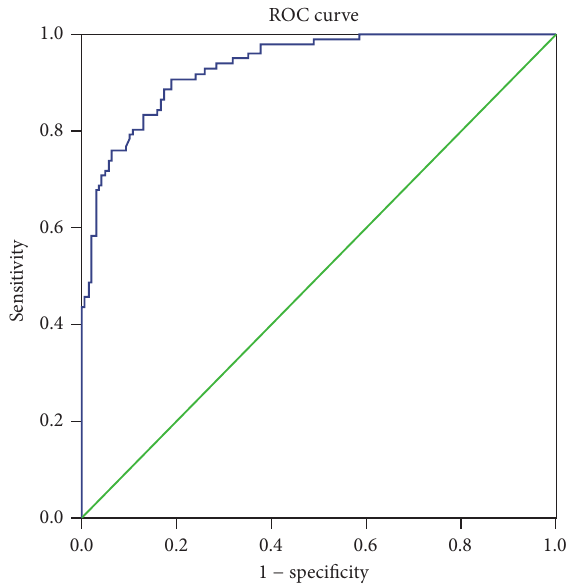
Figure 2: Receiver operating characteristic curve of superior articular process area for prediction of lumbar foraminal spinal stenosis. The best cut-off point of superior articular process area was 112.12mm 2 , with sensitivity of 84.4%, specificity of 83.9%, and AUC of 0.94. AUC: area under the curve .